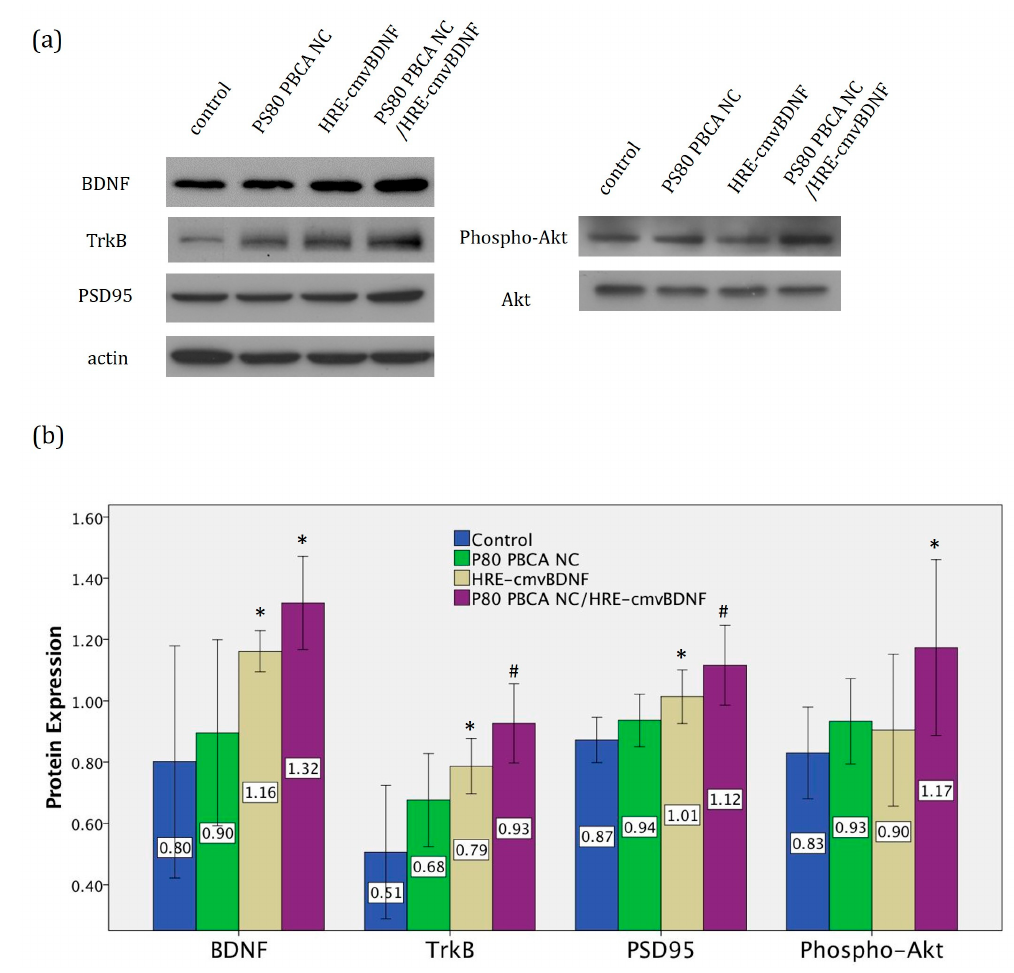
Figure 10. ( a ) Western blot analysis of BDNF, TrkB, PSD95 and Phospho-Akt after two days of transfection; the PS80 PBCA NC/HRE-cmvBDNF-treated cells displayed the strongest band intensities for all the proteins specified above. ( b ) Semi-quantitative analysis of Western blot; the plot shows a progressive rise in the expression level of the respective proteins for the HRE-cmvBDNF and PS80 PBCA NC/HRE-cmvBDNF-treated groups, being most significant in the latter. PBCA NC (30 µ g/mL), HRE-cmvBDNF (2 µ g/mL) and PBCA NC/HRE-cmvBDNF (30 µ g/mL:2 µ g/mL; r = 15:1). n = 4; # p < 0.001; * p < 0.05, compared to control.